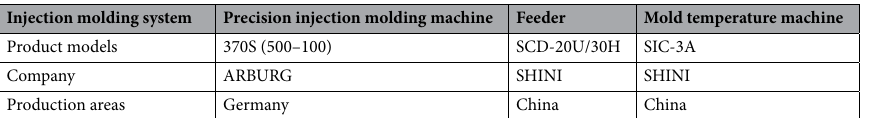
Injection molding system Precision injection molding machine